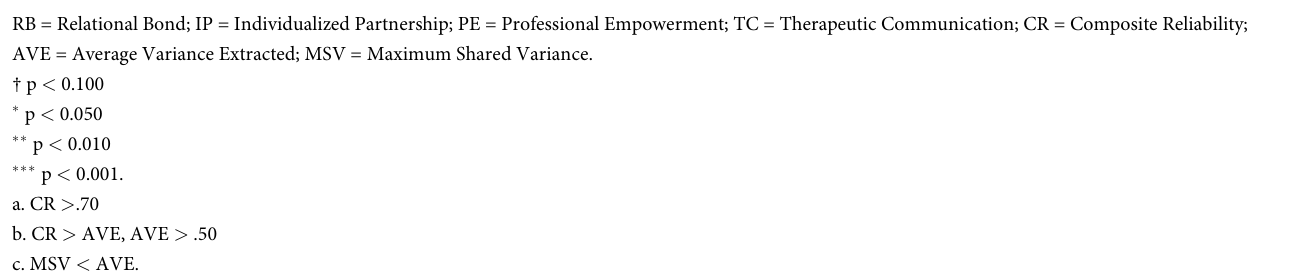
RB = Relational Bond; IP = Individualized Partnership; PE = Professional Empowerment; TC = Therapeutic Communication; CR = Composite Reliability;